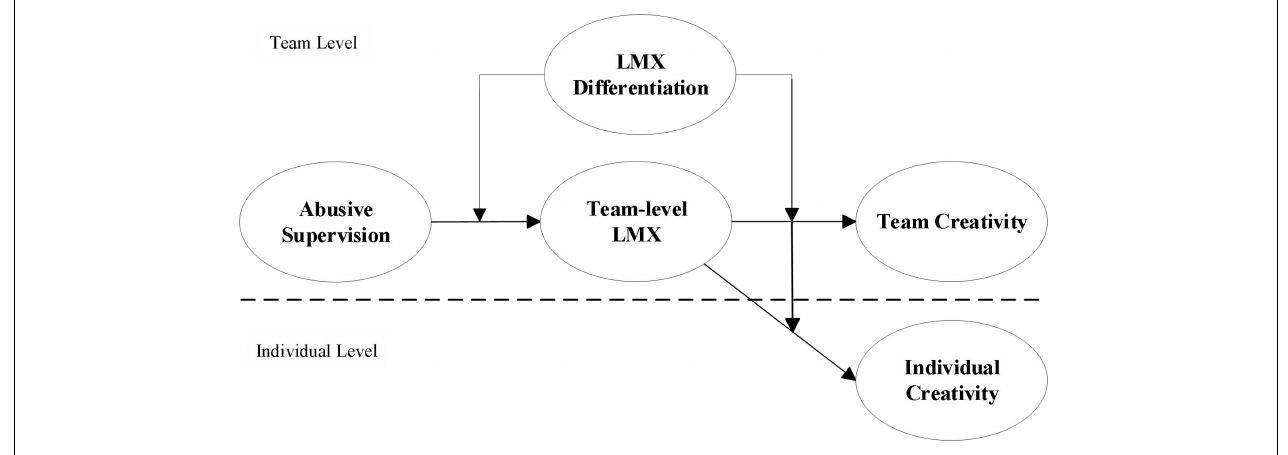
FIGURE 1 | Hypothesized research